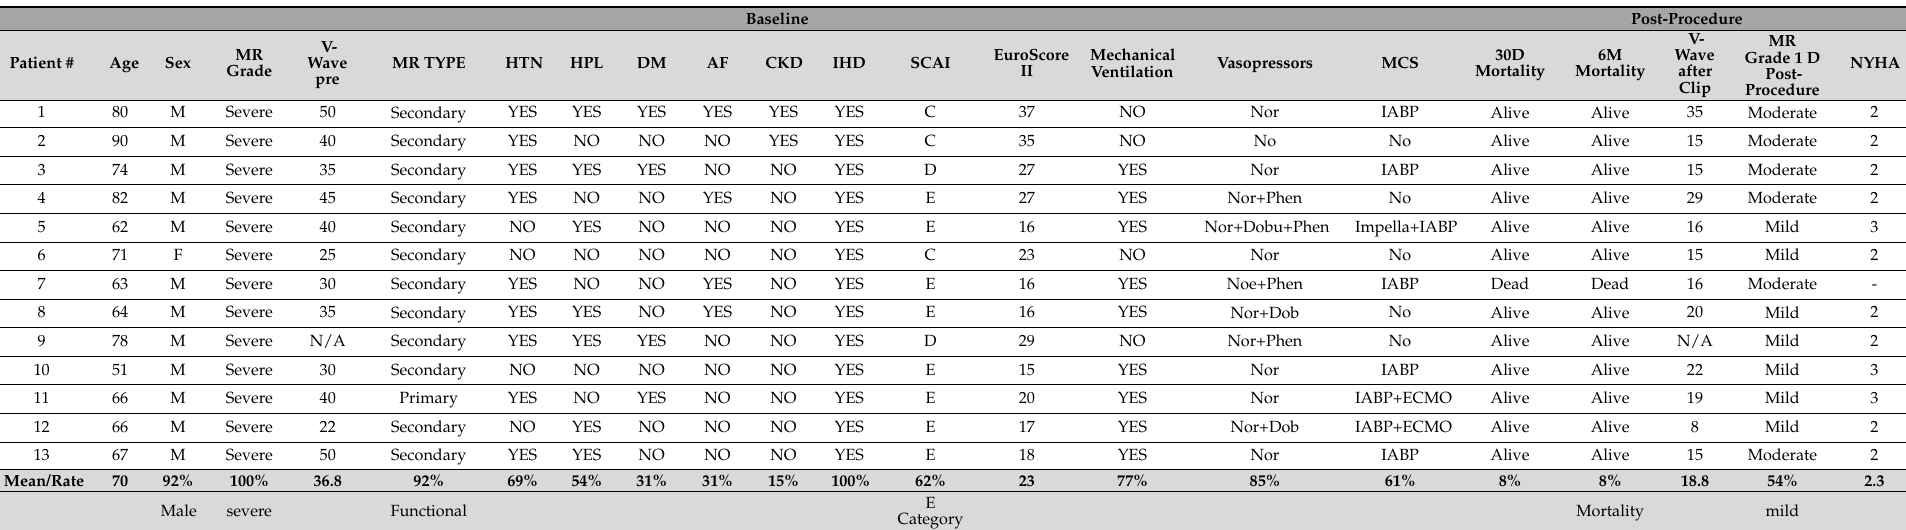
Table 1. Baseline patient characteristics, procedure outcome and follow-up